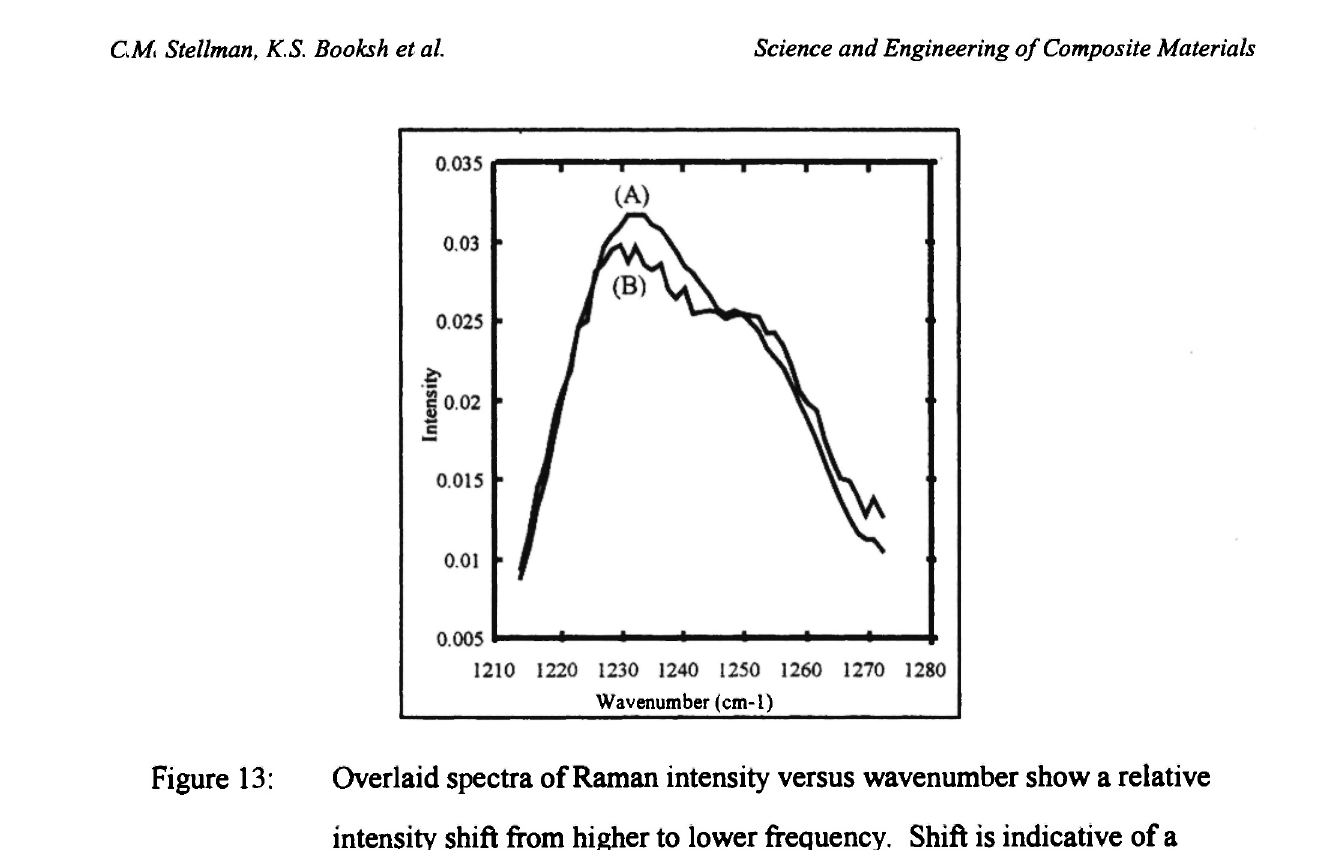
Figure 13: Overlaid spectra of Raman intensity versus wavenumber show a relative intensity shift from higher to lower frequency. Shift is indicative of a difference in cure percentage. (A) Lower cure. (B) Higher